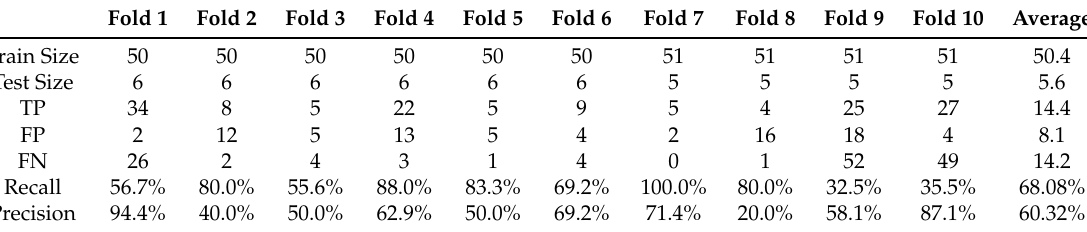
Table A3. The Results of Experiment 3: Augment 50% of dataset (Dataset 3).